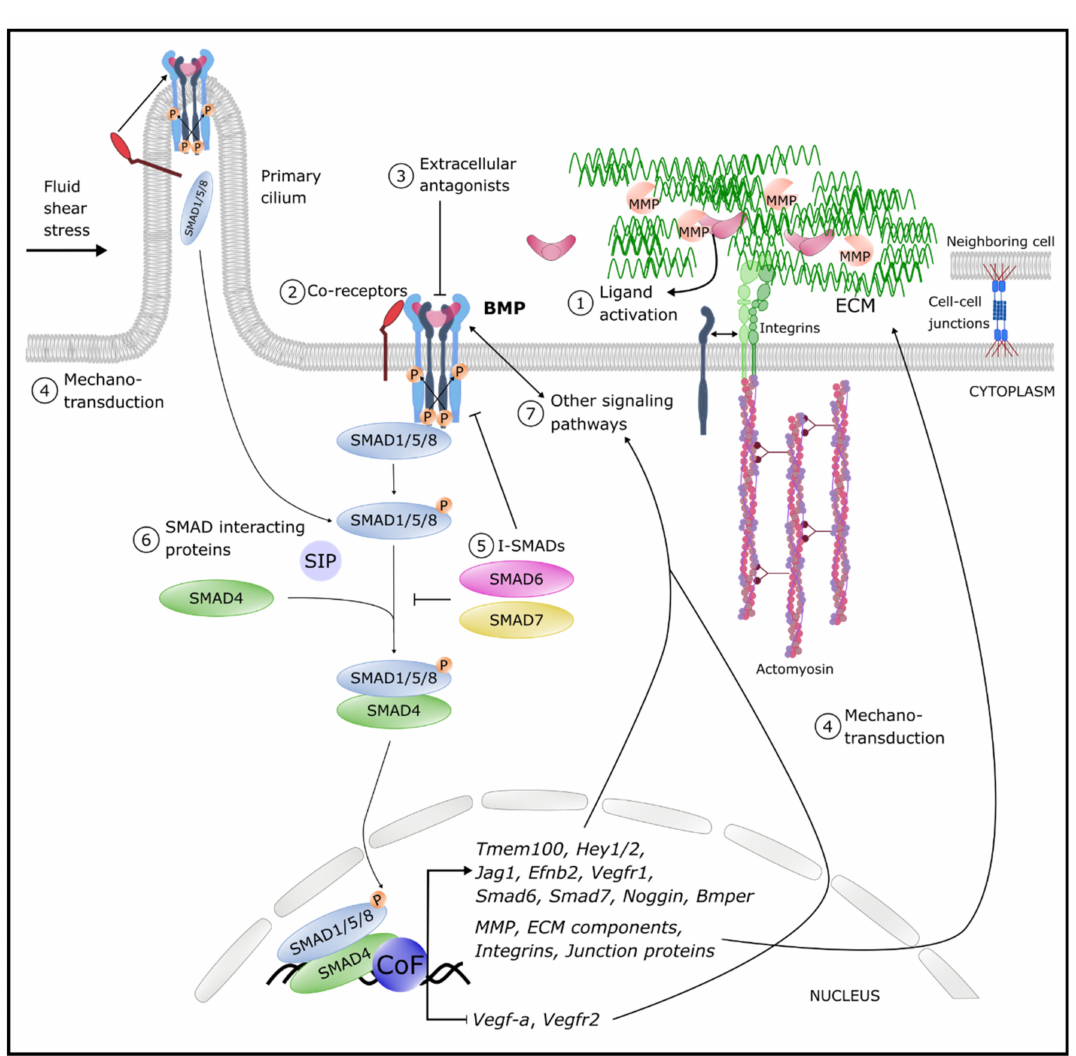
Figure 2. Overview of the different levels of BMP pathway fine-tuning. Circled numbers denote examples of levels of regulation of the signaling output. Cell–cell junctions are tight, adherence and gap junctions (details are provided in the text). Abbreviations: BMP: bone morphogenetic protein BMPER: BMP endothelial cell precursor-derived regulator; CoF: co-factors; P: Phosphorylation; ECM: extracellular matrix; Ephb2: Ephrin B2; Hey: hairy/enhancer-of-split related with YRPW motif protein; Jag: Jagged; MMP: Matrix metalloproteinases; SIP: SMAD interacting proteins; Tmem100: transmembrane protein 100; Vegf: vascular endothelial growth factor; Vegfr: VEGF